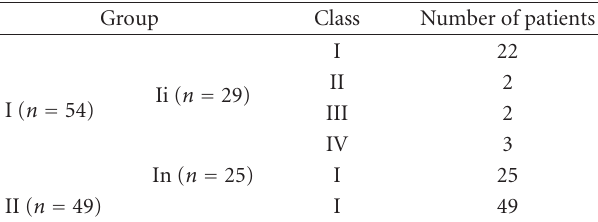
Table 4: Comparison of clinical signs of heart failure evaluated by the Rosse’s heart failure in infants classification in studied groups.